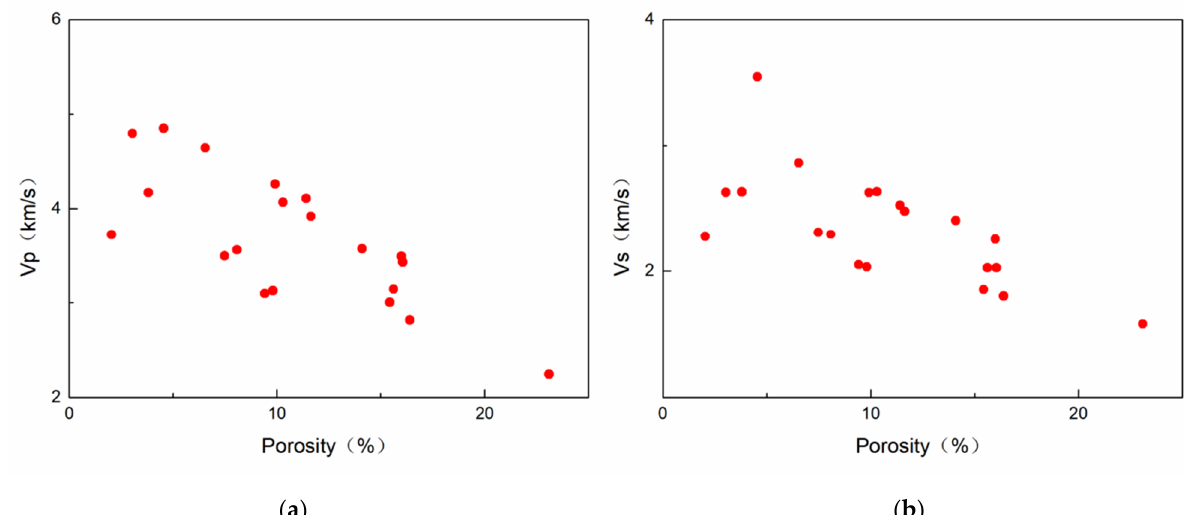
Figure 3. Porosity versus ( a ) P- and ( b ) S-wave velocity. Table 1. Elastic parameters and density of common minerals [12].